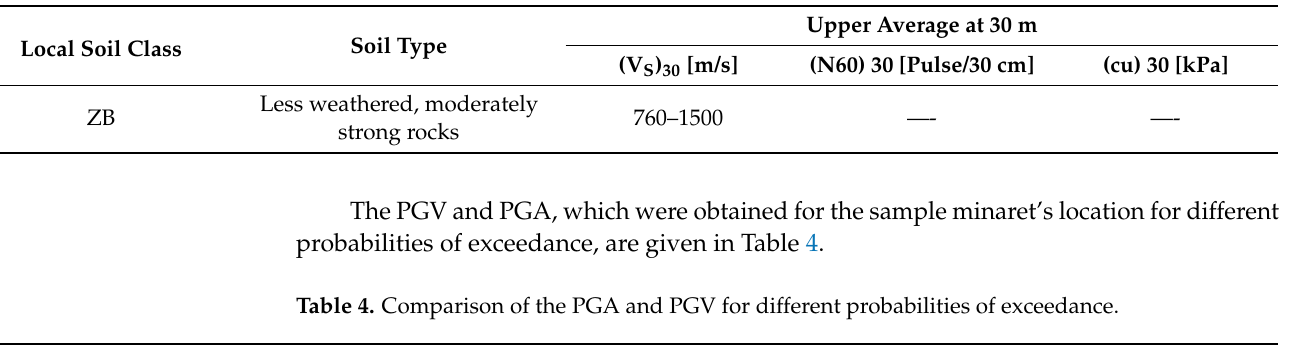
Table 3. Properties of the local ground class type ZB [74].